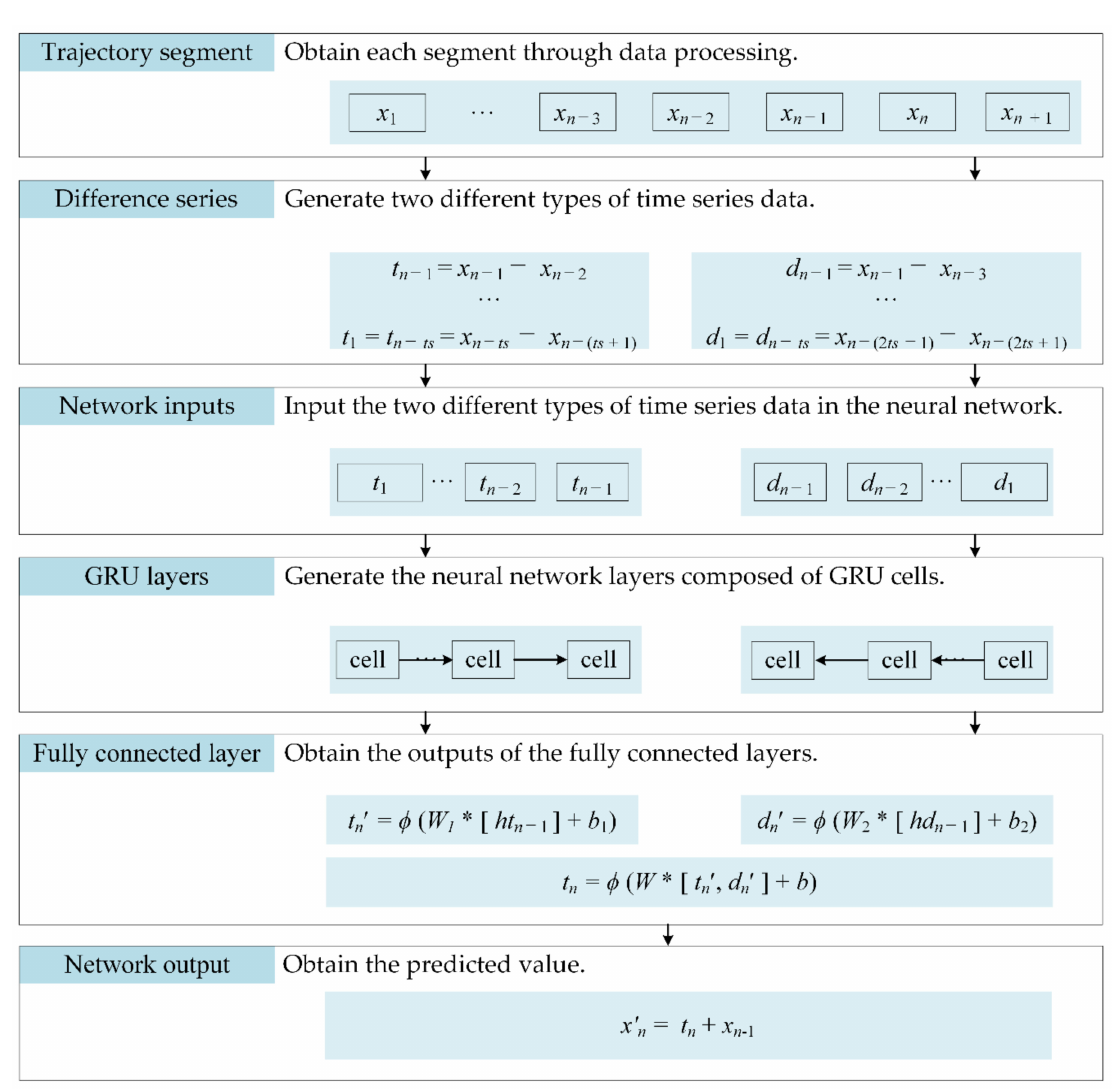
Figure 8. The bidirectional gated recurrent unit (D-GRU)